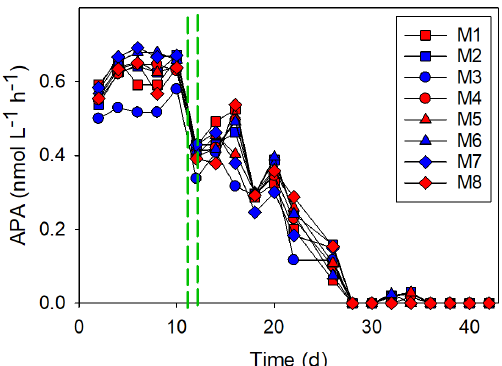
Figure 7. The alkaline phosphatase activity (APA). The red and blue colors denote the mesocosm bags with the addition of water with a low (closer to shore) and very low (further offshore) oxygen min- imum zone (OMZ) signature, respectively. The green dashed lines denote the time of OMZ-water